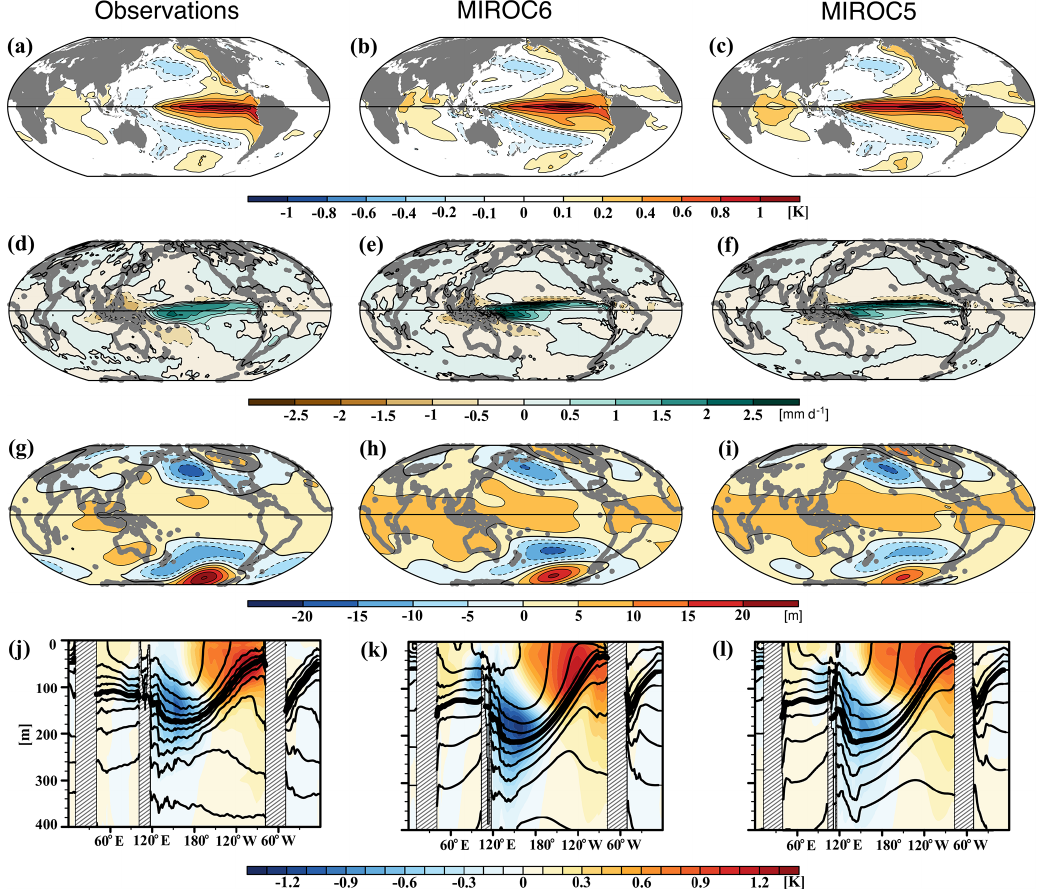
Figure 26. Anomalies of SST (K), precipitation (mmd − 1 ), the 500hPa pressure height (m), and the equatorial ocean temperature averaged over 5 ◦ S–5 ◦ N (K), which are regressed onto the Niño3 index. Monthly anomalies with respect to monthly climatology are used here. From the left to the right, the anomalies in observations (ProjD and ERA-I), MIROC6, and MIROC5 are aligned. Contours (j–l) denote annual mean climatological temperature with the 20 ◦ C isotherms thickened, and the contour interval is 2 ◦ C. Table 3. Radiative forcing of CO 2 doubling and climate feedback for MIROC6 and MIROC5, evaluated with different components of TOA radiation as longwave clear sky (LWclr), shortwave clear sky (SWclr), longwave cloud radiative effect (LCRE), and shortwave cloud radiative effect (SCRE). The MIROC6 results marked with an asterisk ( ∗ ) are different from MIROC5 at the 5%